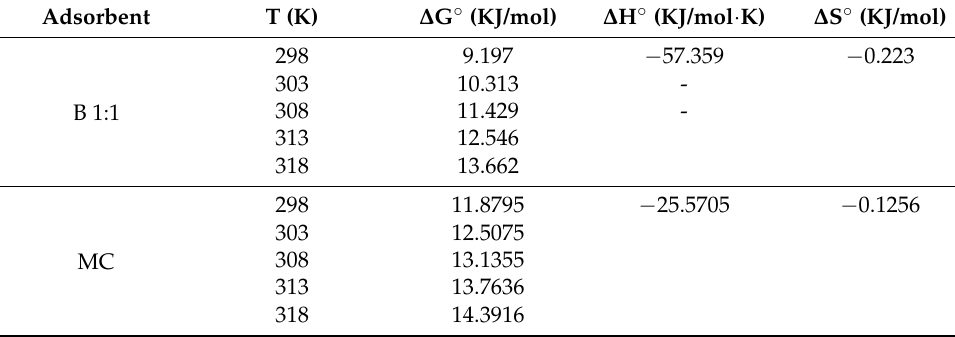
Table 4. Thermodynamic parameters of sulfate